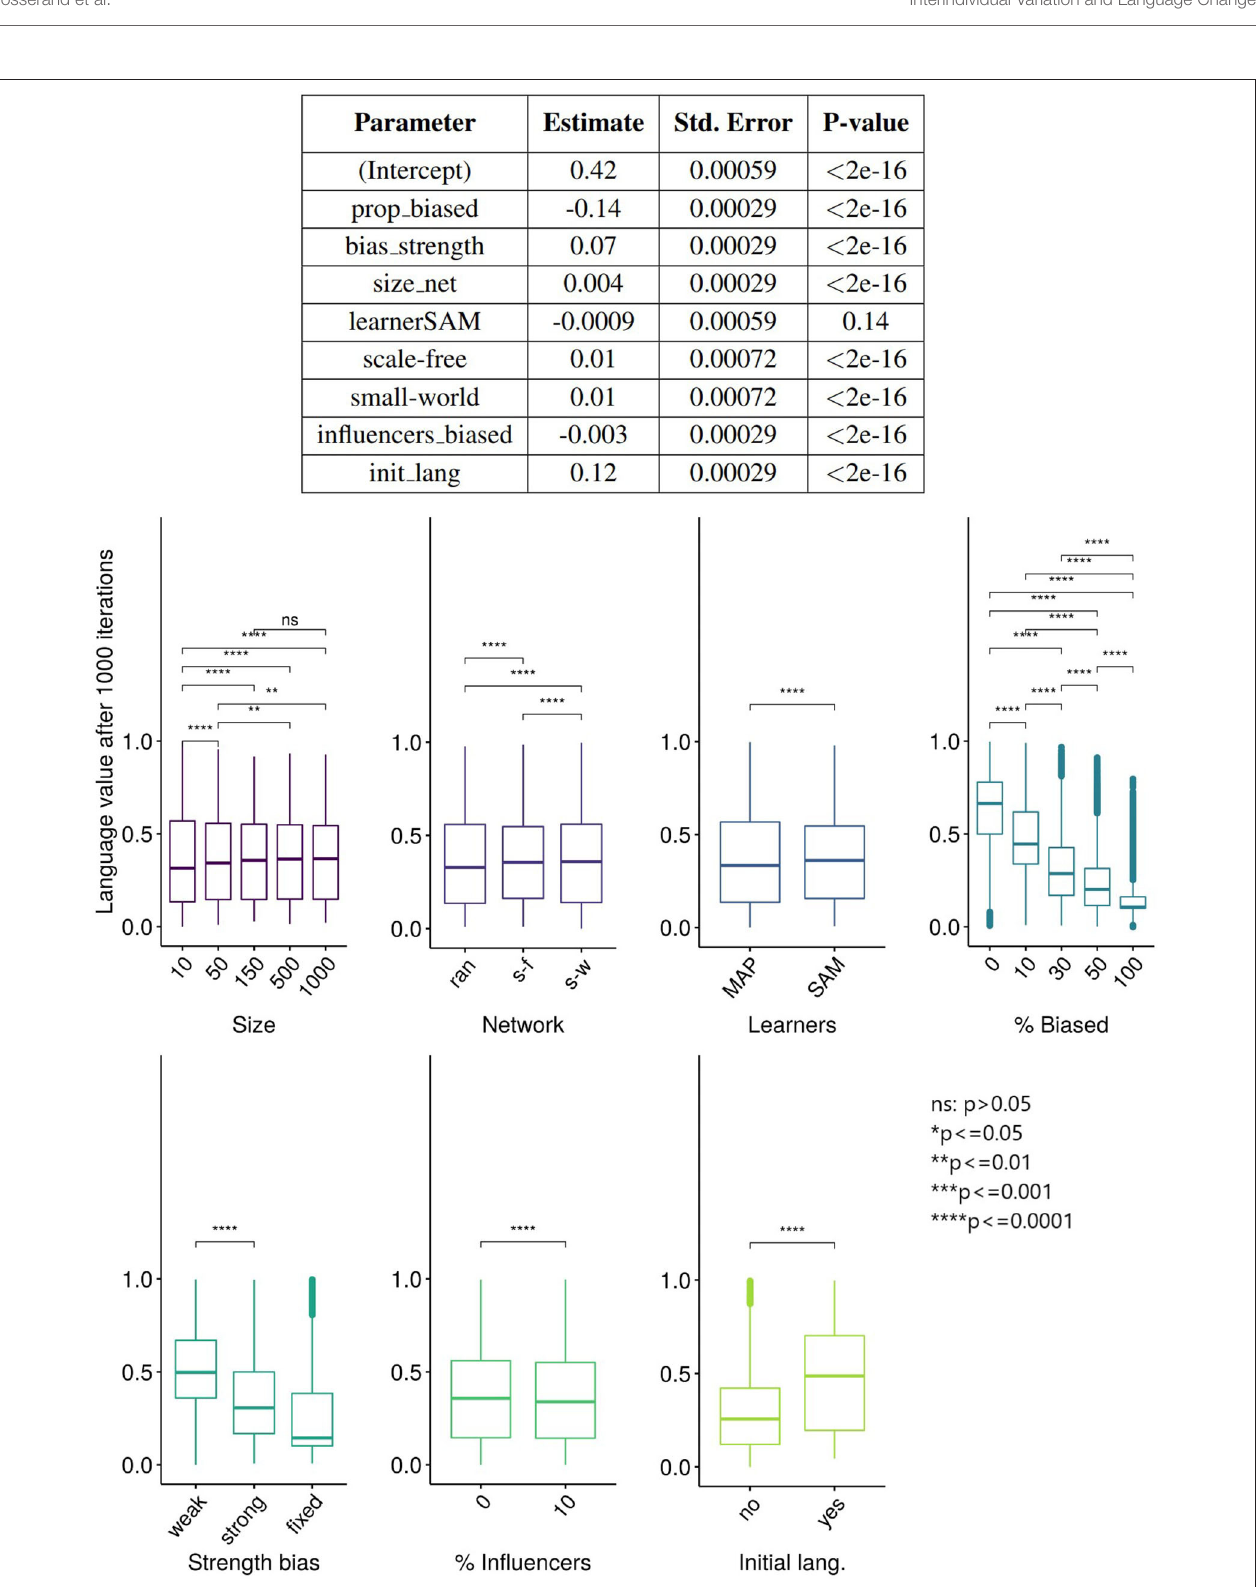
FIGURE 7 | (Top) The results of the linear regression of the language values of all agents after 5,000 ticks on various parameters. Degrees of freedom (df) = 119,991, adjusted R2 = 79.4%. The variable “learner” is a factor with two levels (SAM and MAP) and treatment contrast, with the baseline level MAP included in the intercept. The same applies to the variable “network,” with “random” being the baseline level included in the intercept. (Bottom) The results of unpaired Wilcoxon tests (with adjusted significance stars, where ns: p > 0.05; * p < = 0.05; ** p < = 0.01; *** p < = 0.001; **** p < = 0.0001) between the language values (vertical axis) across multiple replications vs. the parameters (horizontal